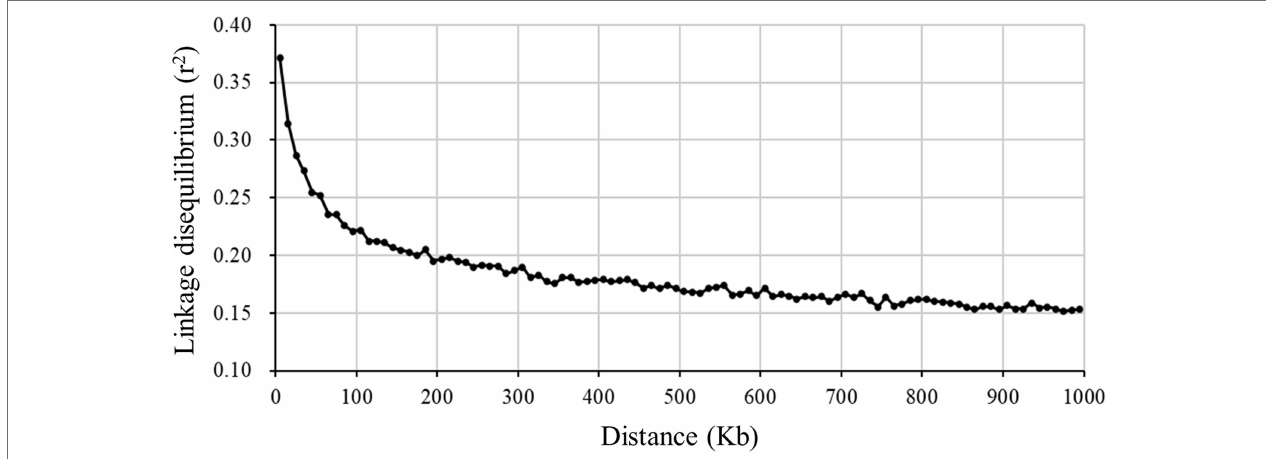
FIGURE 5 | Decay of average linkage disequilibrium ( r 2 ) over distance (Kb) between markers for a composite pig